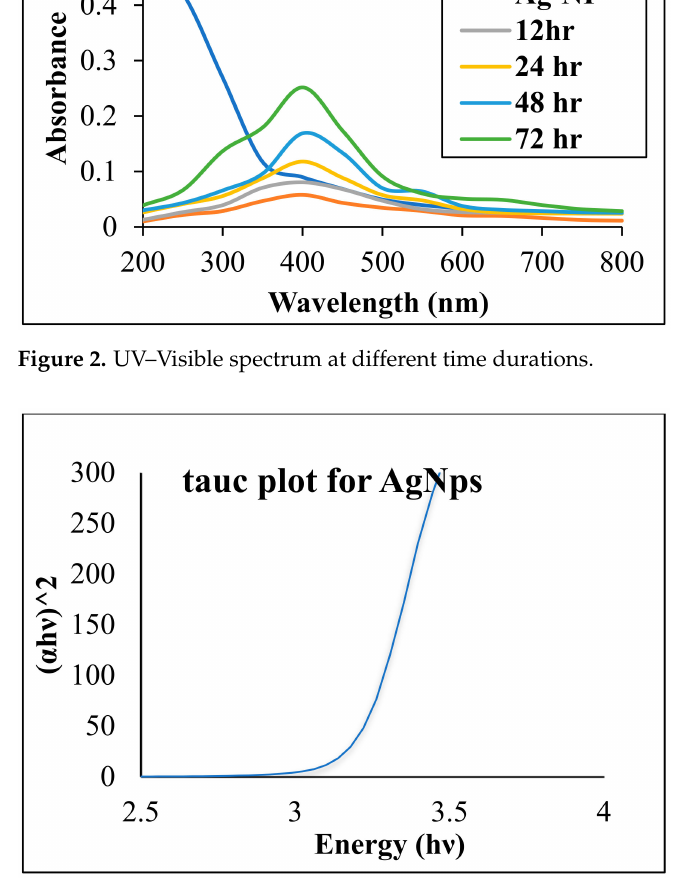
Figure 3. Energy Bandgap determined using Tauc